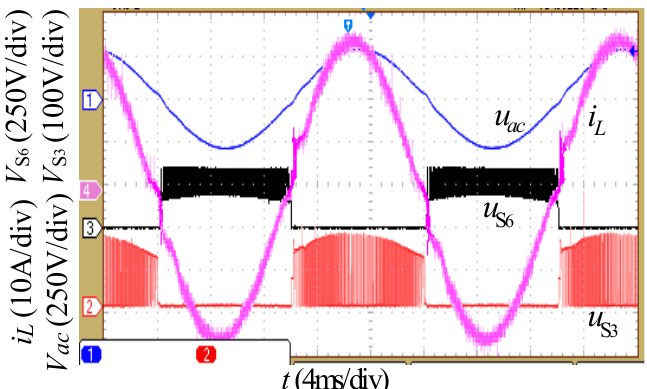
Figure 19. Terminal voltage of switches and inductor current MMI. Appl. Sci. 2018 , 8 , x FOR PEER REVIEW